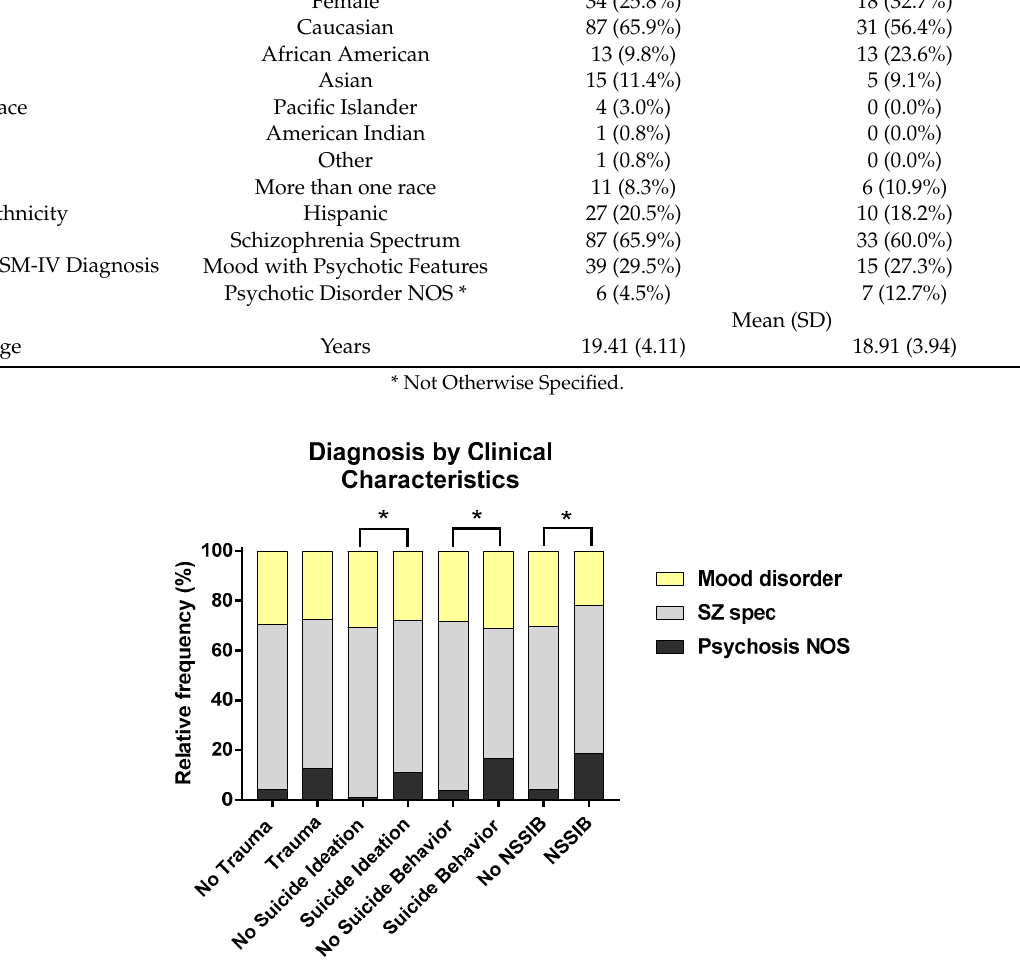
Figure 1. Proportions of participants with and without a history of trauma, suicide ideation, suicide behavior, and non-suicidal self-injury behavior (NSSIB) differed for those with psychosis NOS diagnoses. * p < 0.05